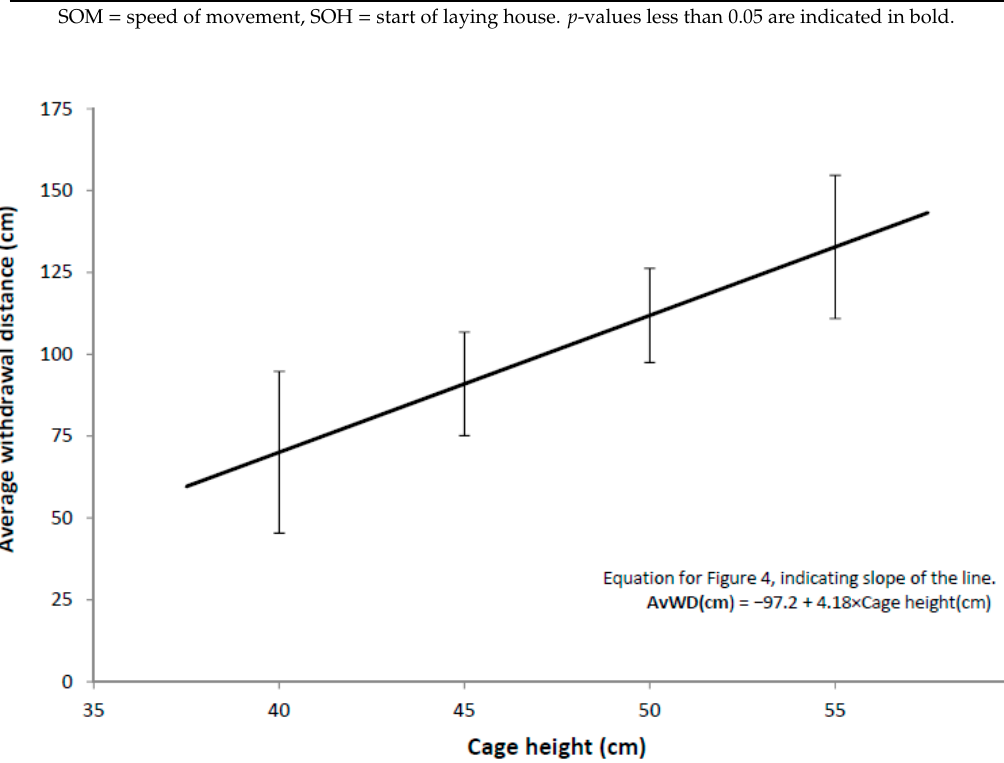
Figure 4. Relationship between average withdrawal distance in the Stroll Test and cage height. Error bars represent 95% confidence intervals.